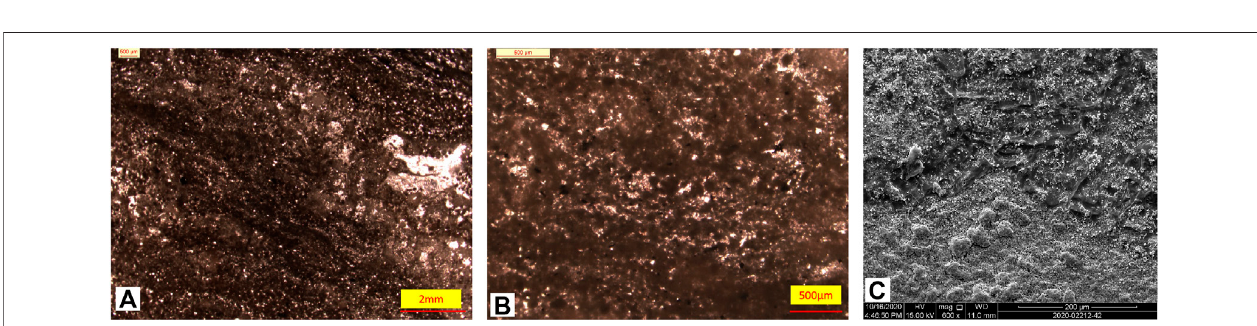
FIGURE 2 | Microphotographs of stromatolite observed with optical microscopy (A,B) and SEM (C) .